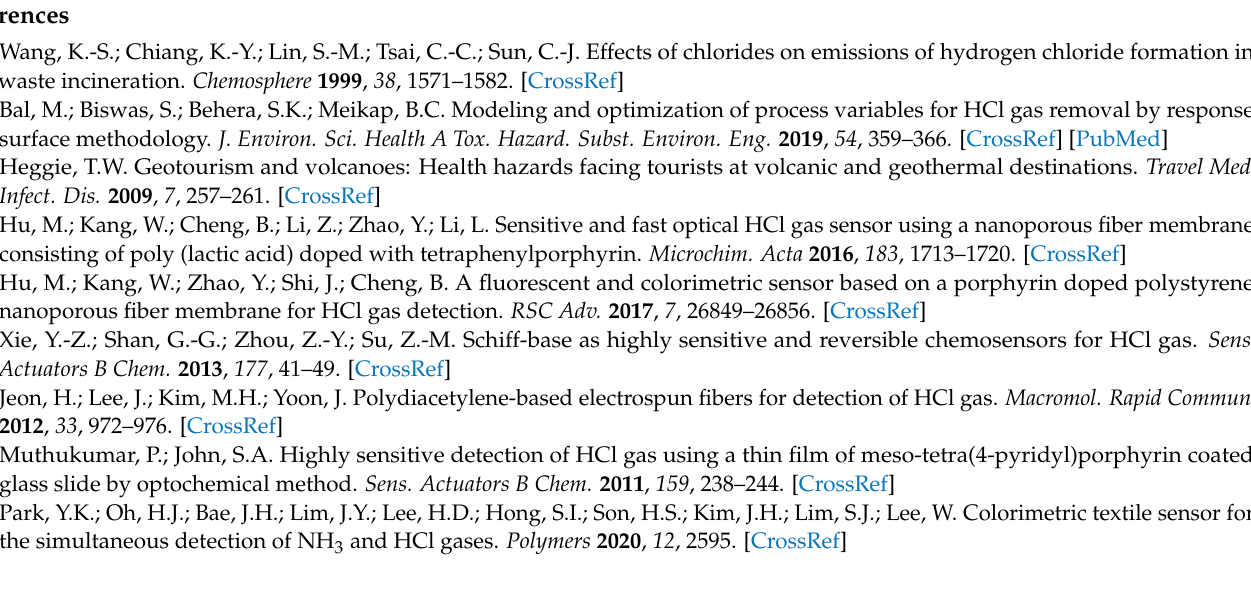
(b) 11.8 µ g, respectively. All scale bars are 1 µ m. Figure S2: Resonant frequency change ( ∆ f ) as a function of time for poly(DMAEMA-co-EGDMA) and poly(DMAA-co-EGDMA) films in 70-ppm HCl, and synthetic air flow at 22 ◦ C (10% RH). The adsorption–desorption process was performed until the signal stabilized. Figure S3: Resonant frequency change ( ∆ f ) as a function of time for poly(DMAEMA- co-EGDMA) and poly(DMAA-co-EGDMA) films in 100-ppm HCl and N 2 flow at 22 ◦ C (10% RH). A three cycle adsorption–desorption process was performed. Figure S4: XPS wide scan spectra for poly(DMAEMA-co-EGDMA) and poly(DMAA-co-EGDMA) films before and after HCl adsorption. Figure S5: Resonant frequency change ( ∆ f ) as a function of time for (a) poly(DMAEMA-co-EGDMA) and (b) poly(DMAA-co-EGDMA) films in HCl gas flow ranging from 10 to 70 ppm, at 22 ◦ C and 10% RH during the adsorption process. Synthetic air was used for desorption, and the desorption pro- cess was performed until the signal stabilized. Figure S6: Linear regression curve of poly(DMAEMA- co-EGDMA) for resonant frequency change ( ∆ f ) as a function of HCl concentration in HCl ranging from 10 to 50 ppm. Table S1: Comparison of HCl on various sensor configurations, including the sensitivity and limit of detection in a linear range [14,17,19,22,32]. Table S2: Fitting parameters of